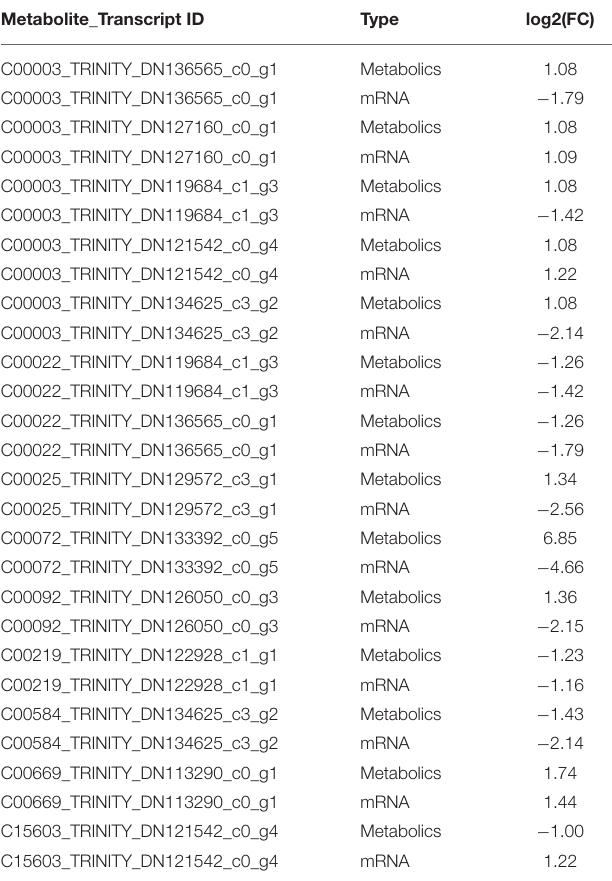
TABLE 5 | Results of differential co-expression of hypothalamic metabolites and related transcripts in